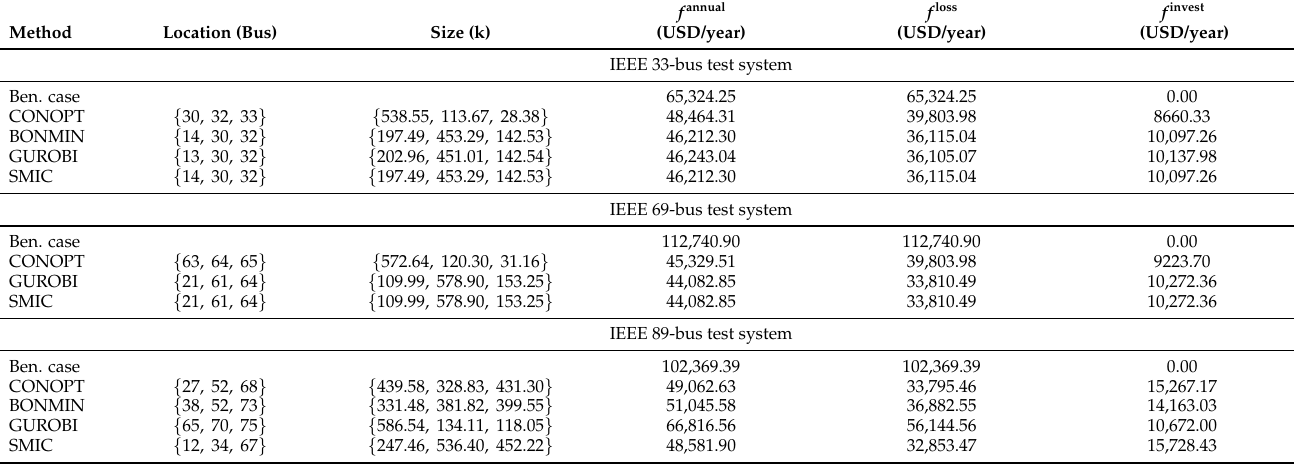
Table 4. Optimal location and size reached by the proposed SMIC model and the GAMS